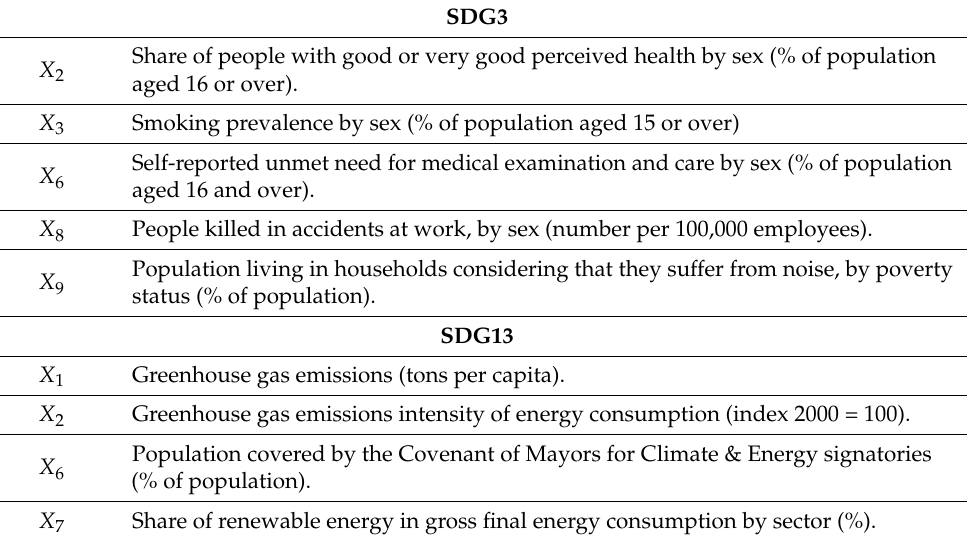
Table 1. Set of variables accepted for the